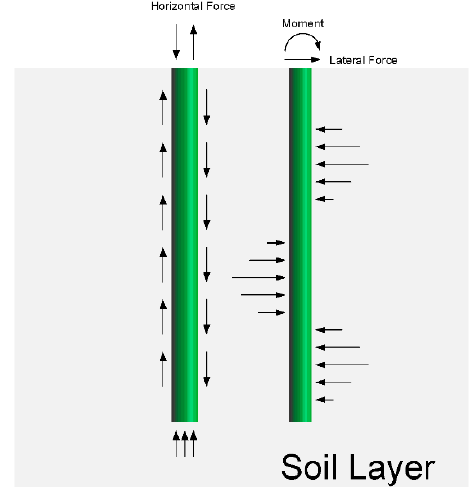
Figure 5. Definition of pile-soil interaction.